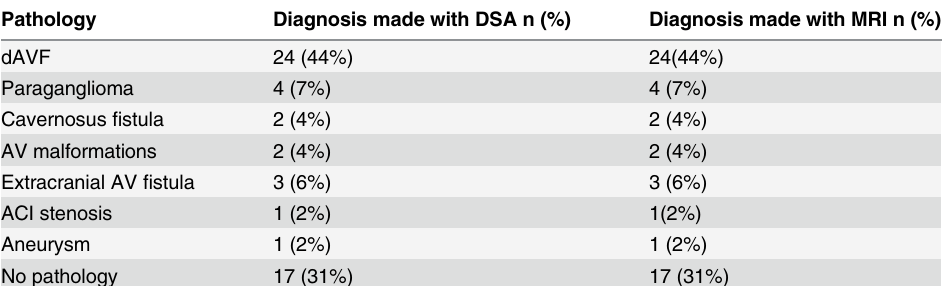
Table 1. Patient group with PT according to fi nal diagnosis based on DSA and